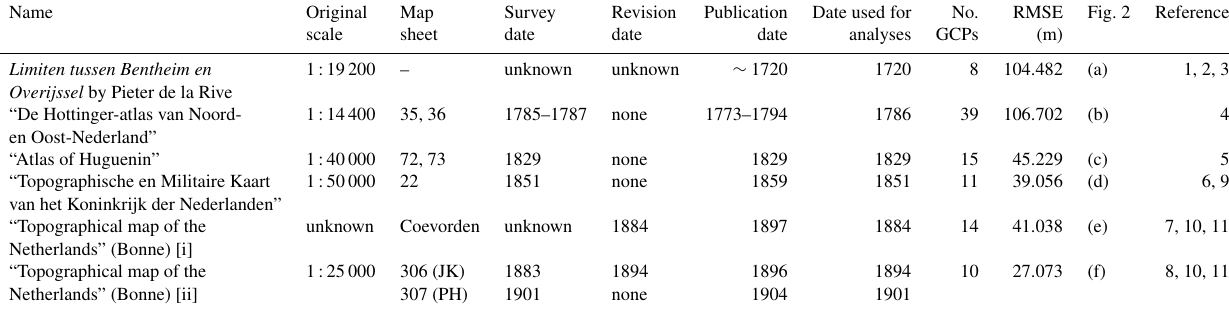
Table 1. Overview of the six historical maps used in this study. All dates are indicated in CE (Common Era). Revision date indicates full or partial revision. The date used for analysis is based on the revision date or, if none is given, on the survey date. For the map sheet of the Hottinger atlas the survey covered 3 years; we therefore took the middle year to use in further analyses. GCPs: ground control points (as used for georeferencing); RMSE: root mean square error (expressed in metres) based on the residuals (or displacement vectors) of the GCPs after using a first-order polynomial transformation in the georectification procedure. JK: Junner Koeland; PH: Prathoek. Map sections are shown in Fig. 2. References list map source and publications on cartographers, survey techniques and depiction methods. References are detailed in the